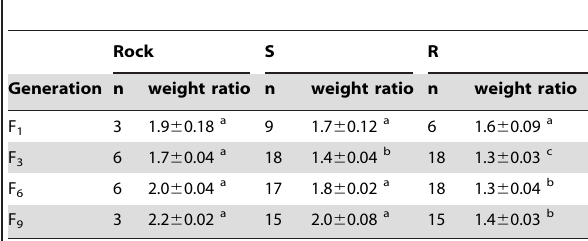
Table 2. Increase of Aedes aegypti adult female weight after a blood meal; comparison among R, S and Rockefeller.